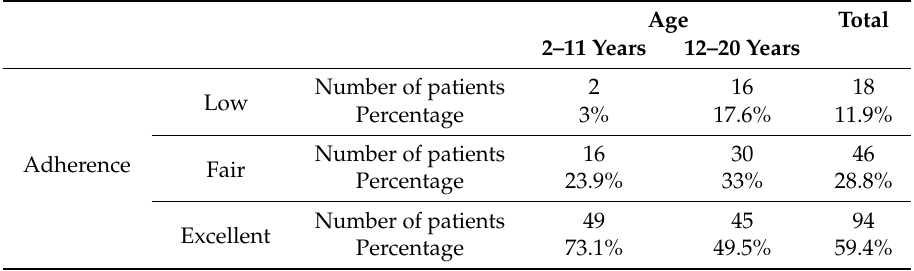
Table 2. Grade of diet adherence in 2 di ff erent groups of age (2–11 and 12–20 years old).